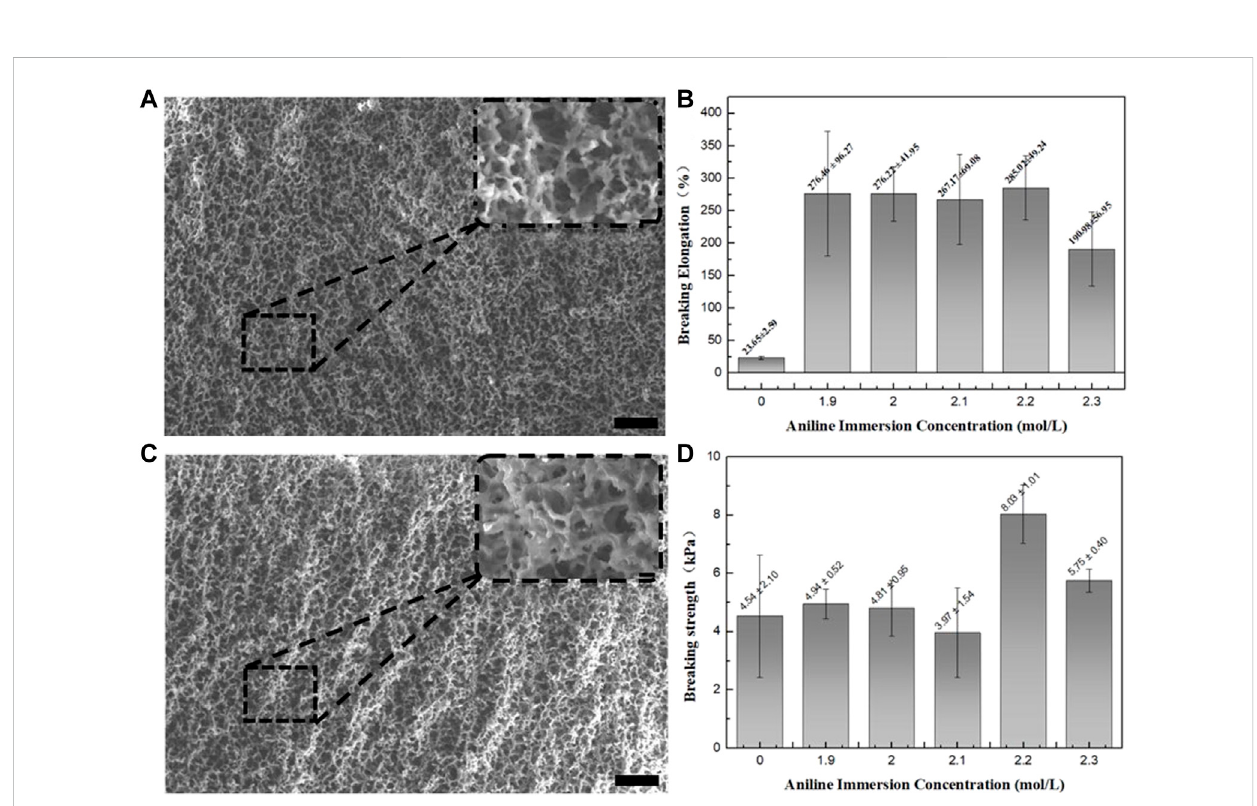
FIGURE 2 (A) SEM image of 1.9 mol/L sample, (B) Elongation at break. (C) SEM image of 2.3 mol/L sample. (D) Tensile fracture